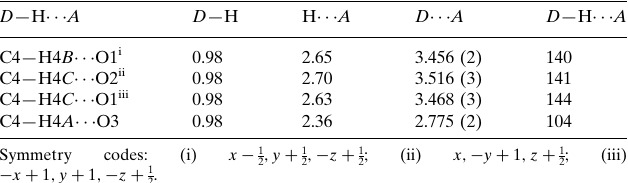
Hydrogen-bond geometry (A˚ , (cid:4)